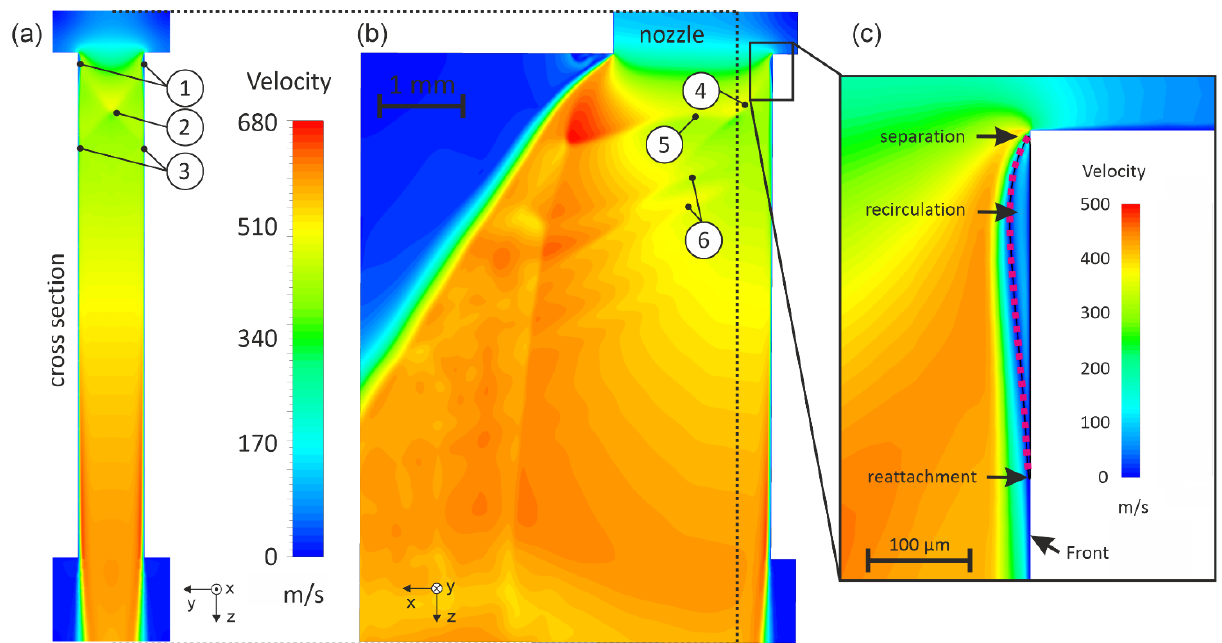
Figure 3. Distributions of velocity magnitude. ( a ) At the cross-section at the beam/nozzle axis; ( b ) at the symmetry plane. ( c ) Enlarged view of the separation, recirculation, and reattachment at the top front corner. Because of the regular kerf shape, the front separation almost coincides with the separation on the top kerf edge corner in ( a ).